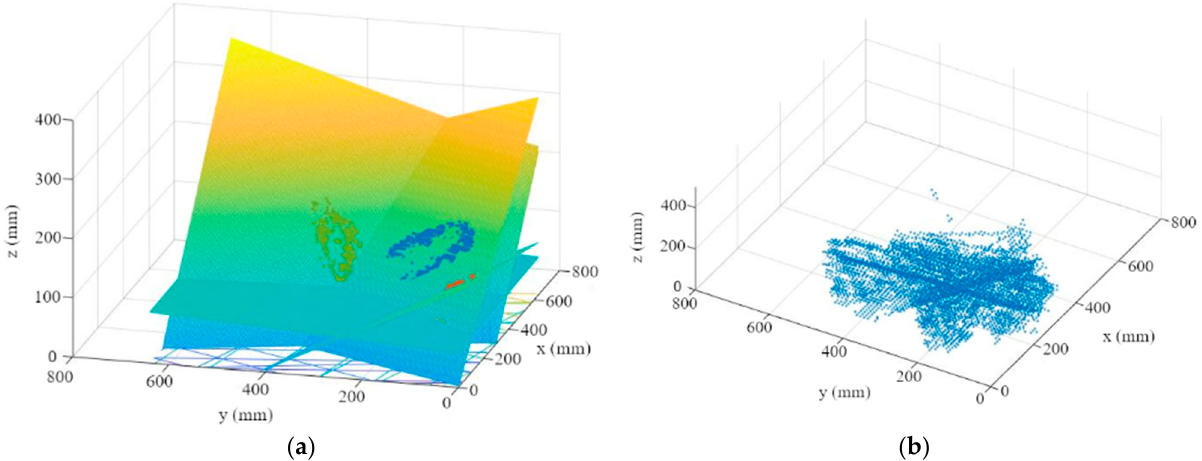
Figure 9. ( a ) Visualization of the first four leaf planes; ( b ) three-dimensional visualization of the plane intersections in the plant area.